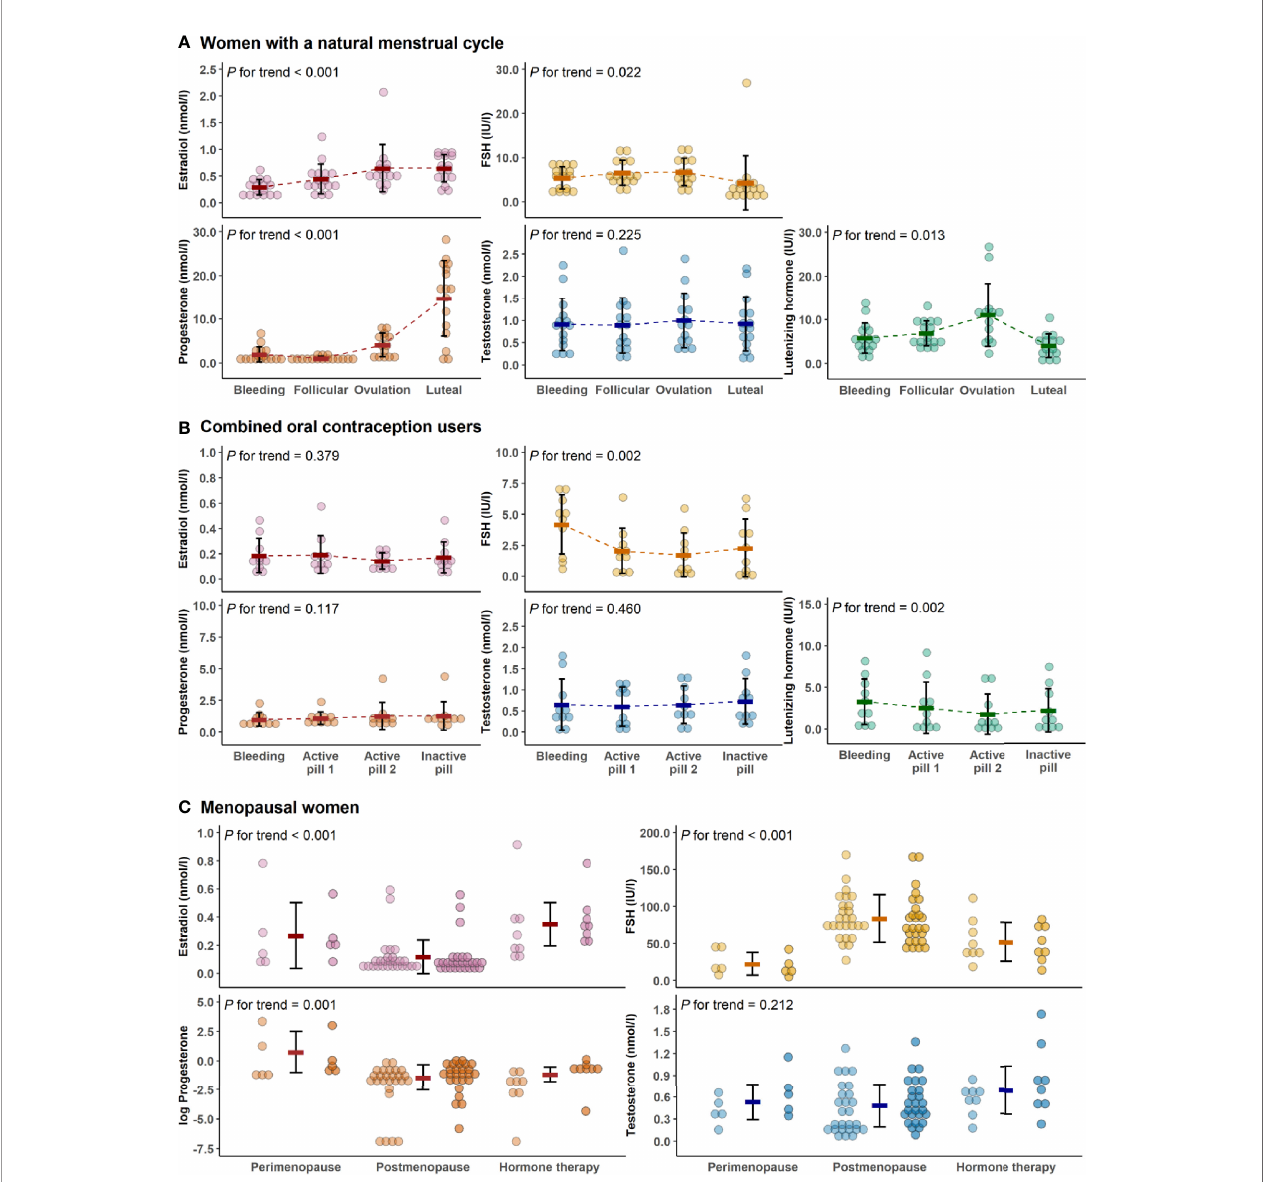
FIGURE 2 | Hormone levels across data collection time points and study groups. Hormone concentrations during the menstrual cycle of the natural reproductive women (A) , during pill cycle of the combined oral contraceptive users (B) and among menopausal women (C) . In all fi gures, bold lines in graphs represent means with standard deviations. For menopausal women, the means were calculated as average concentrations of the two measurement points (the fi rst measurement point is presented with lighter and the second is with darker colors). In C, progesterone was log-transformed for better visualization purposes only. P for trend is provided by Wald Chi-Squared Test of the generalized estimating equation models. FSH, follicle-stimulating